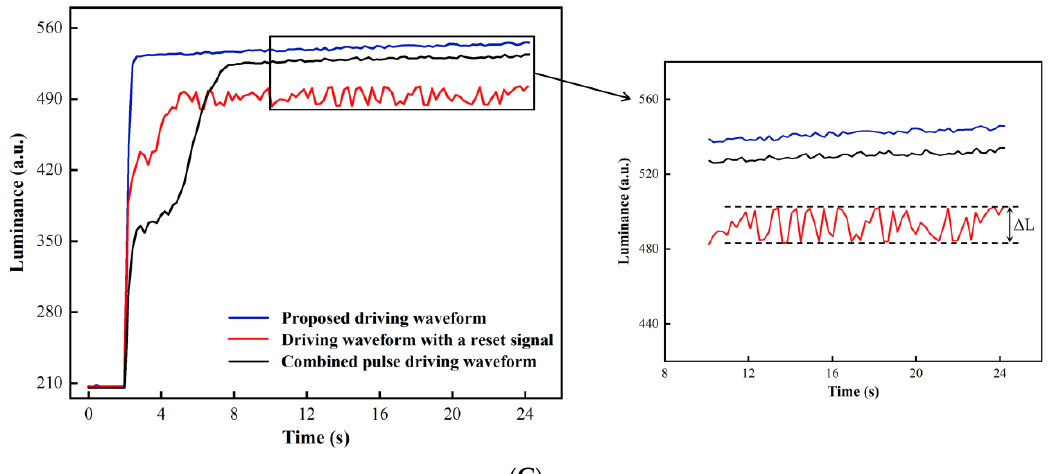
Figure 12. Different driving waveforms for performance comparison. ( A ) Two driving waveforms were used for performance comparison. ( B ) Luminance-time curves of three different driving waveforms. The luminance oscillation would not be produced and a higher saturation luminance could be obtained by the proposed driving waveform in the driving stage. An obvious luminance oscillation would be produced by the other two comparison driving waveforms. ( C ) Luminance variation curves of three different driving waveforms within 24 s. The driving waveform with a reset signal would generate luminance oscillation with an amplitude of ∆ L . However, the phenomenon of charge trapping could be solved effectively and luminance oscillation could be reduced to achieve a stable display of luminance by the proposed driving waveform.